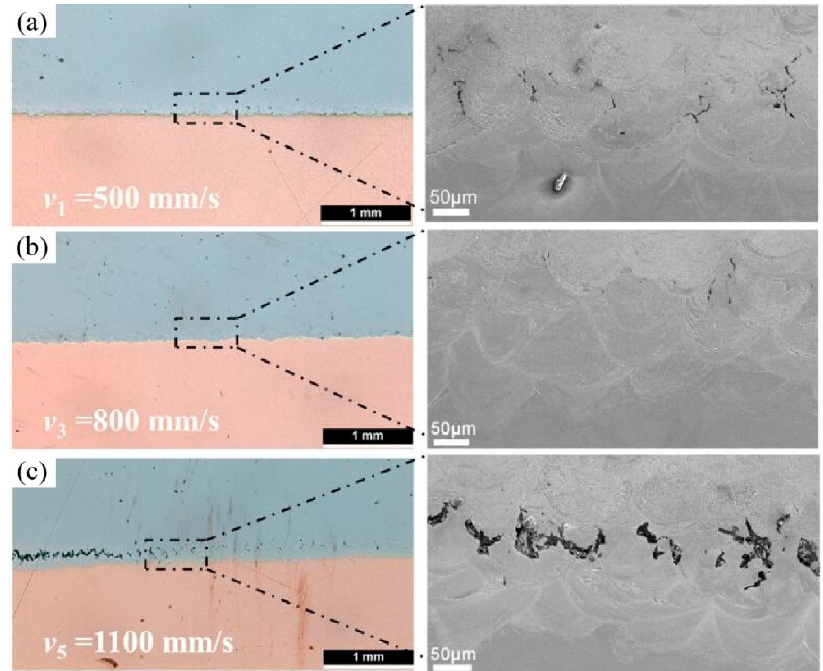
Figure 12. Interfacial defects in the vertical cross sections of LPBF-processed copper–steel specimens observed by optical micrographs and SEM, ( a – c ) indicate the interfacial bonding morphology when scan speed ( v ) is 500 mm/s, 800 mm/s and 1100 mm/s respectively [103].